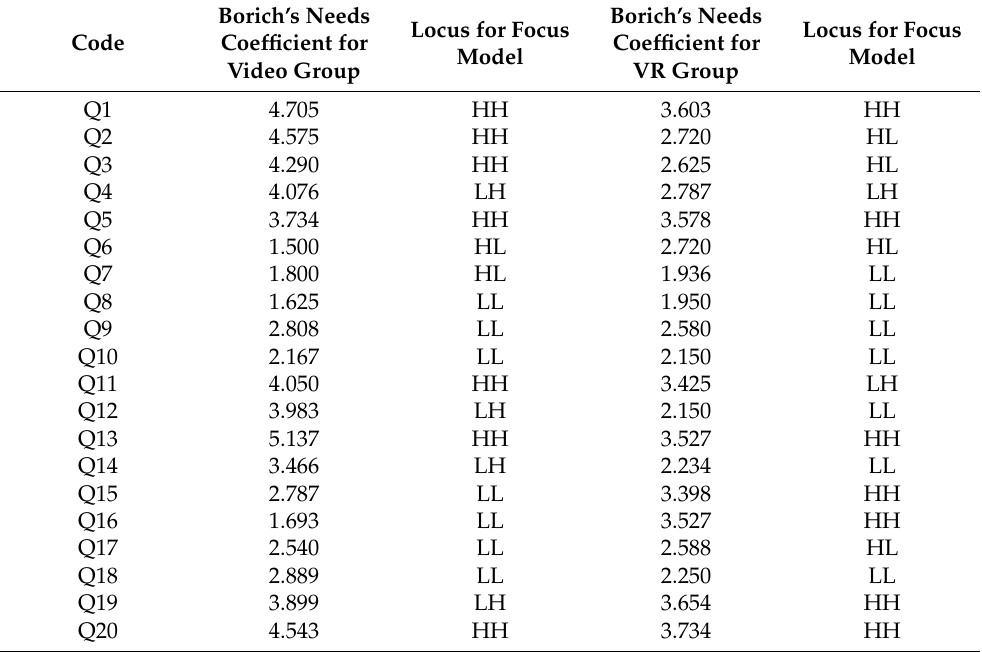
Table 4. Borich’s needs assessment result for Group 1 (video) and Group 2